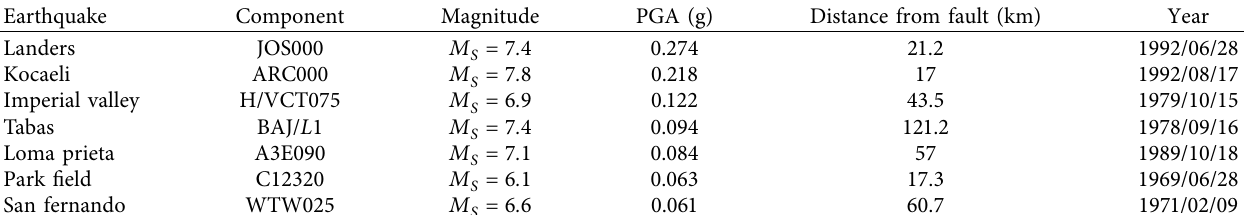
Table 1: Details of near-field earthquake records used in this research (this table is reproduced from) [47]. Earthquake